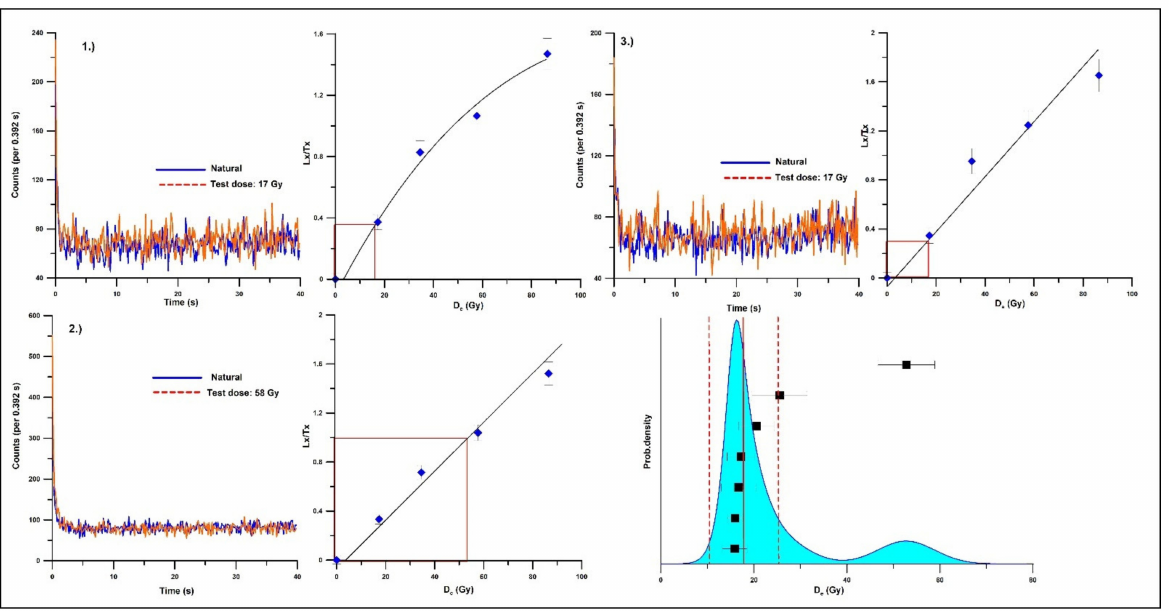
Figure 7. Dose response and decay curves obtained for given (1), (2) and (3) different aliquots of quartz sample HU110103 at the depth of 1000